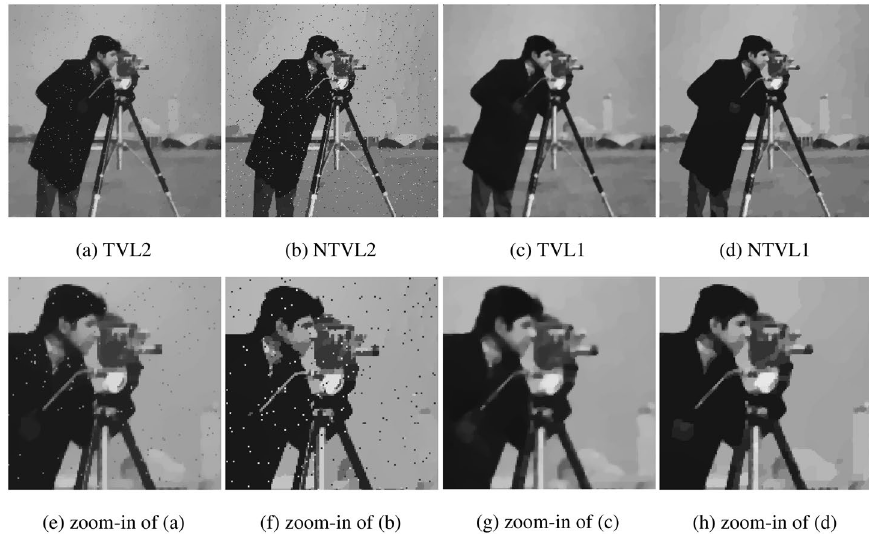
Figure 7. The denoising results of Cameraman contaminated by Gaussian noise ( σ = 0.005 ) and salt and pepper noise ( d = 0.02 ).